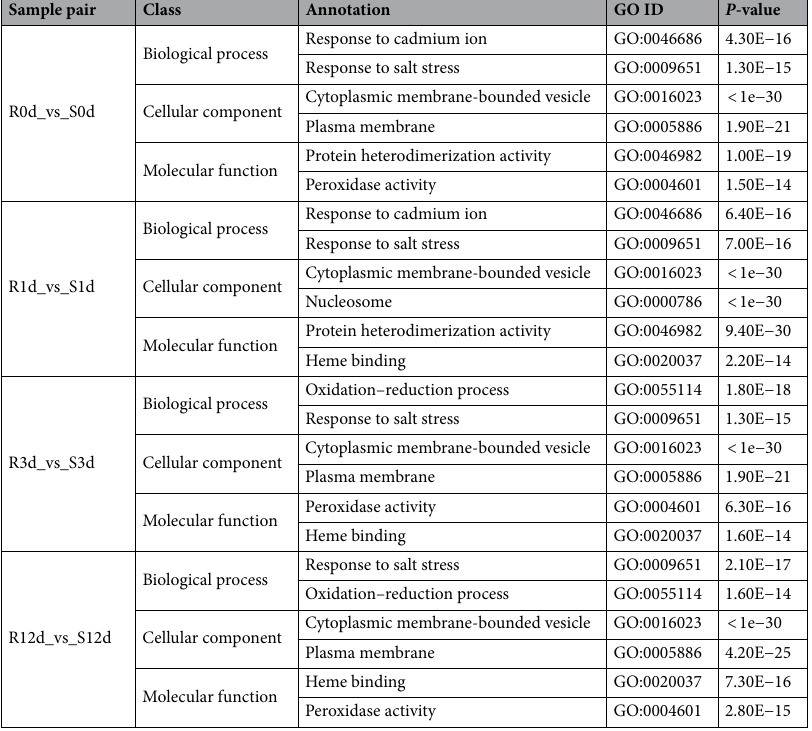
Table 2. Major enrichment terms of the DEGs from the four timepoint groups, referencing the GO database. R and S are the slightly susceptible (SN4143) and highly susceptible (PZSCL6) line, respectively.